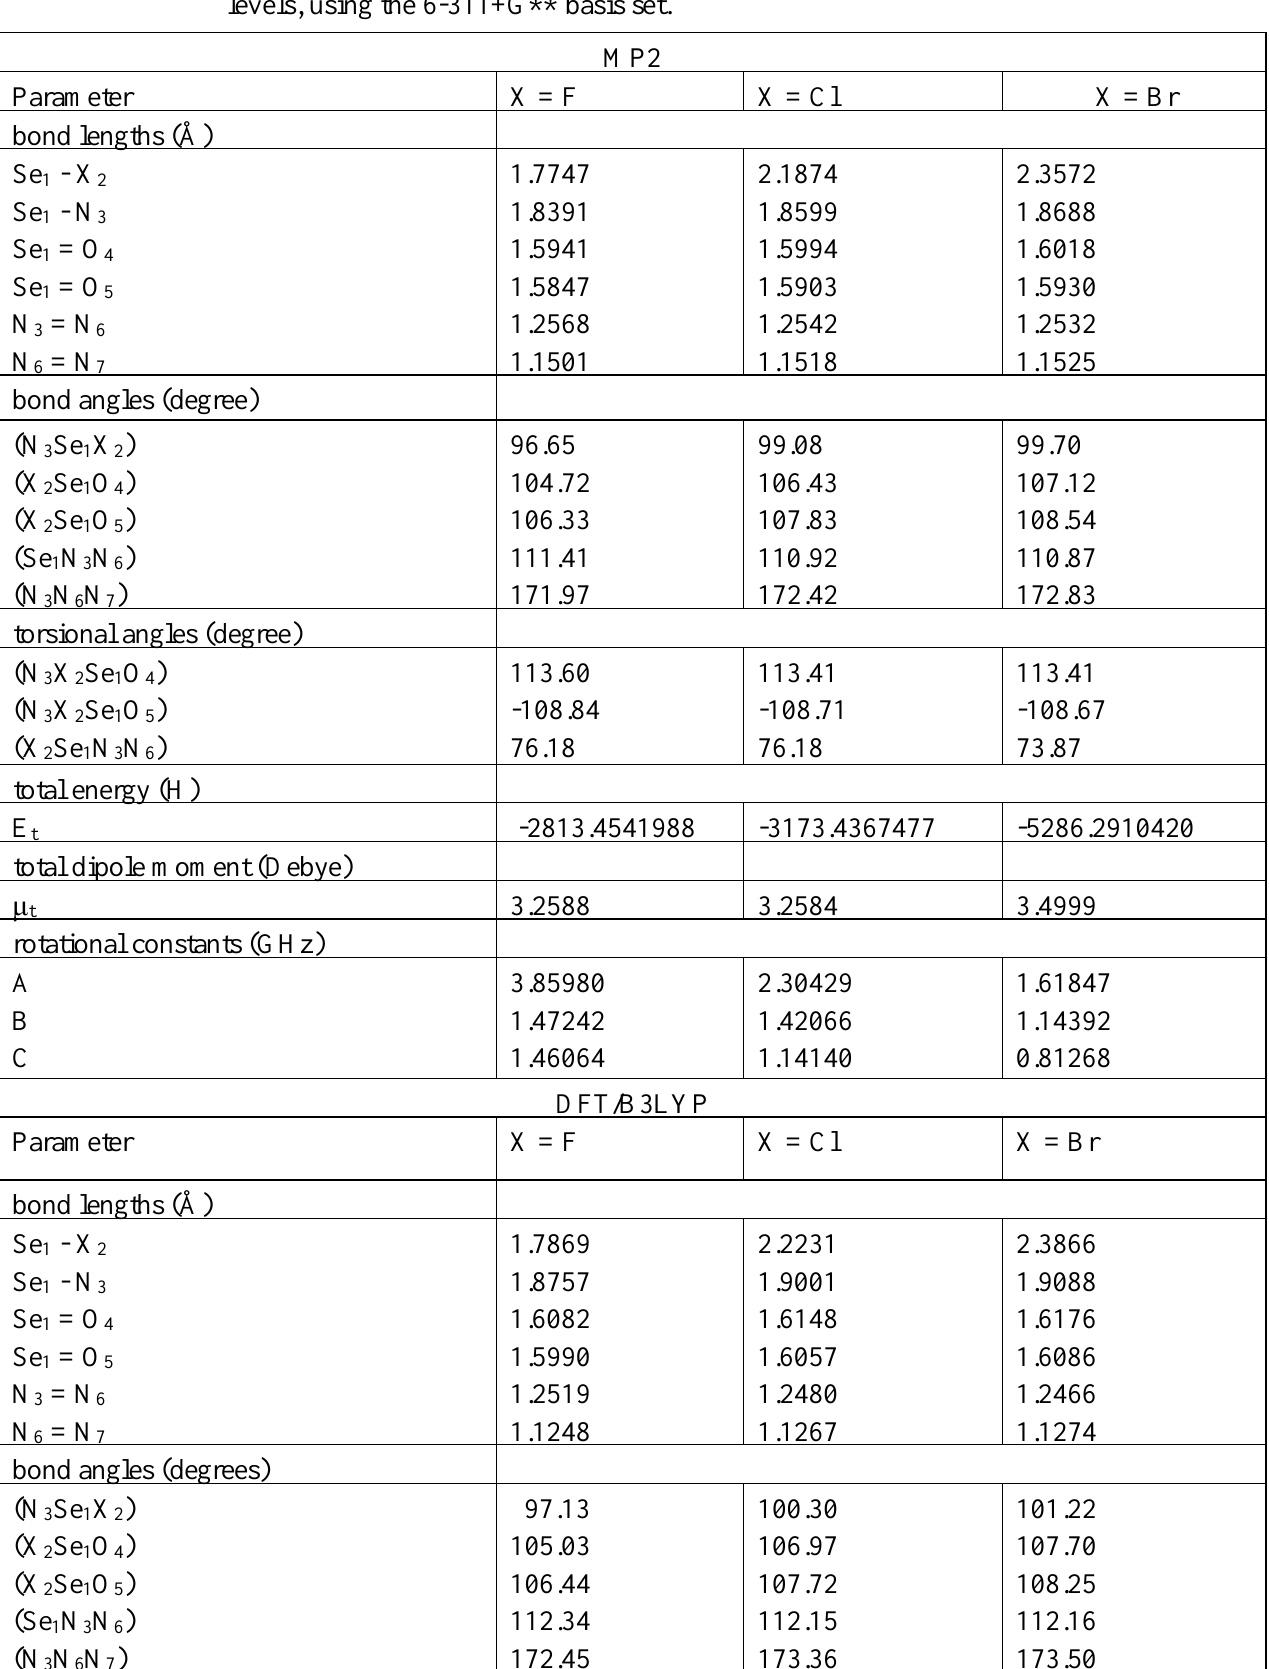
Table 1 : Structural parameters, total dipole moments and rotational constants for the gauche conformer of haloselenonyl azides (X = F, Cl and Br), calculated on MP2 and DFT levels, using the 6-311+G** basis